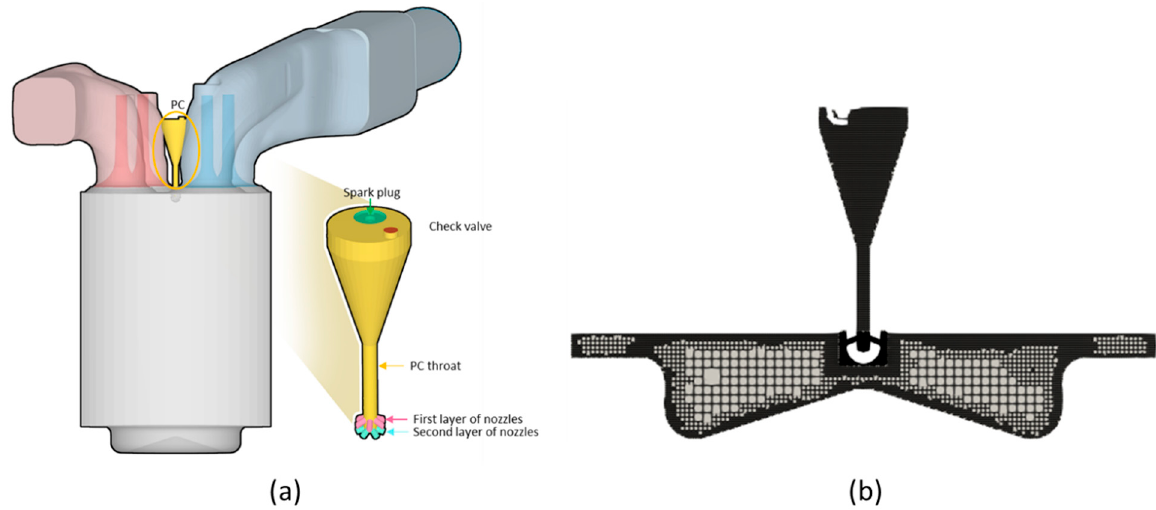
Figure 1. Schematic of: ( a ) computational geometry; and ( b ) grid control technique. Table 1. Engine specifications.